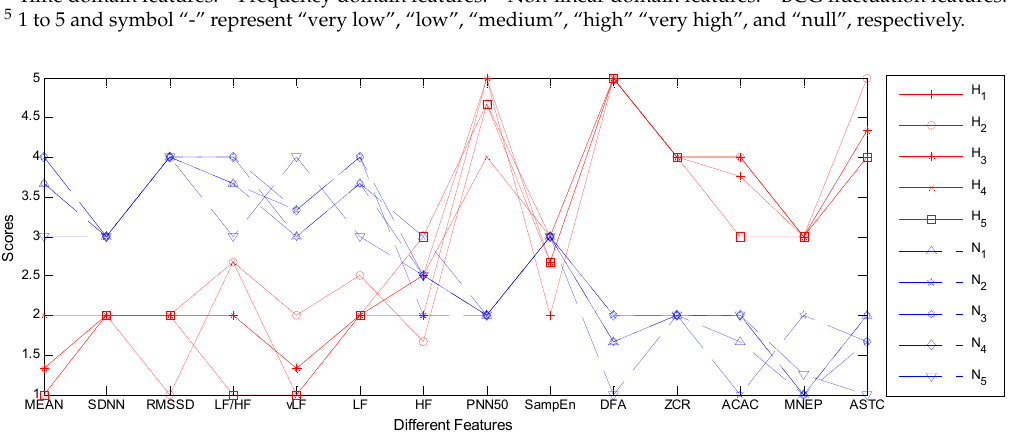
Figure 7. The visualization of the five most powerful CARs in hypertensive group and normotensive group. The null value in CARs are replaced by the average value of current group, and the CARs for hypertensive group and normotensive group are plotted by using red solid line and blue dotted line respectively.